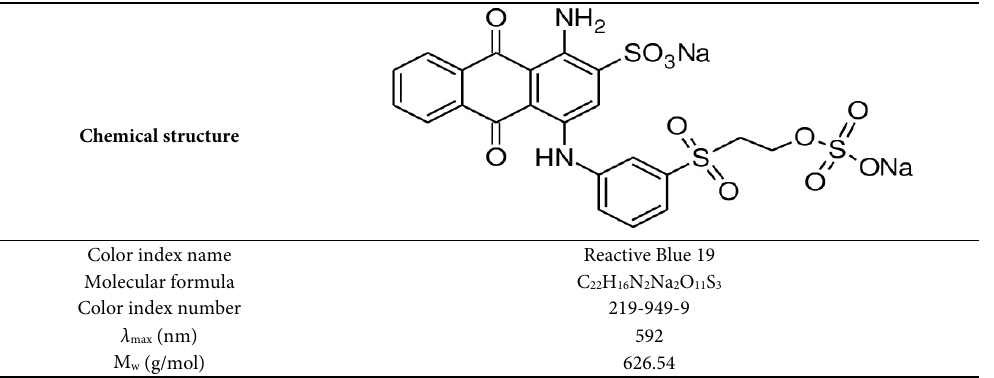
Table 1. The characteristics of C.I. Reactive blue 19